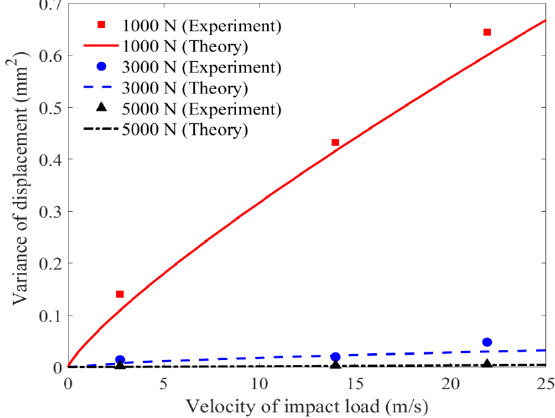
Figure 19. Variance value of displacement versus velocity of impact wind.